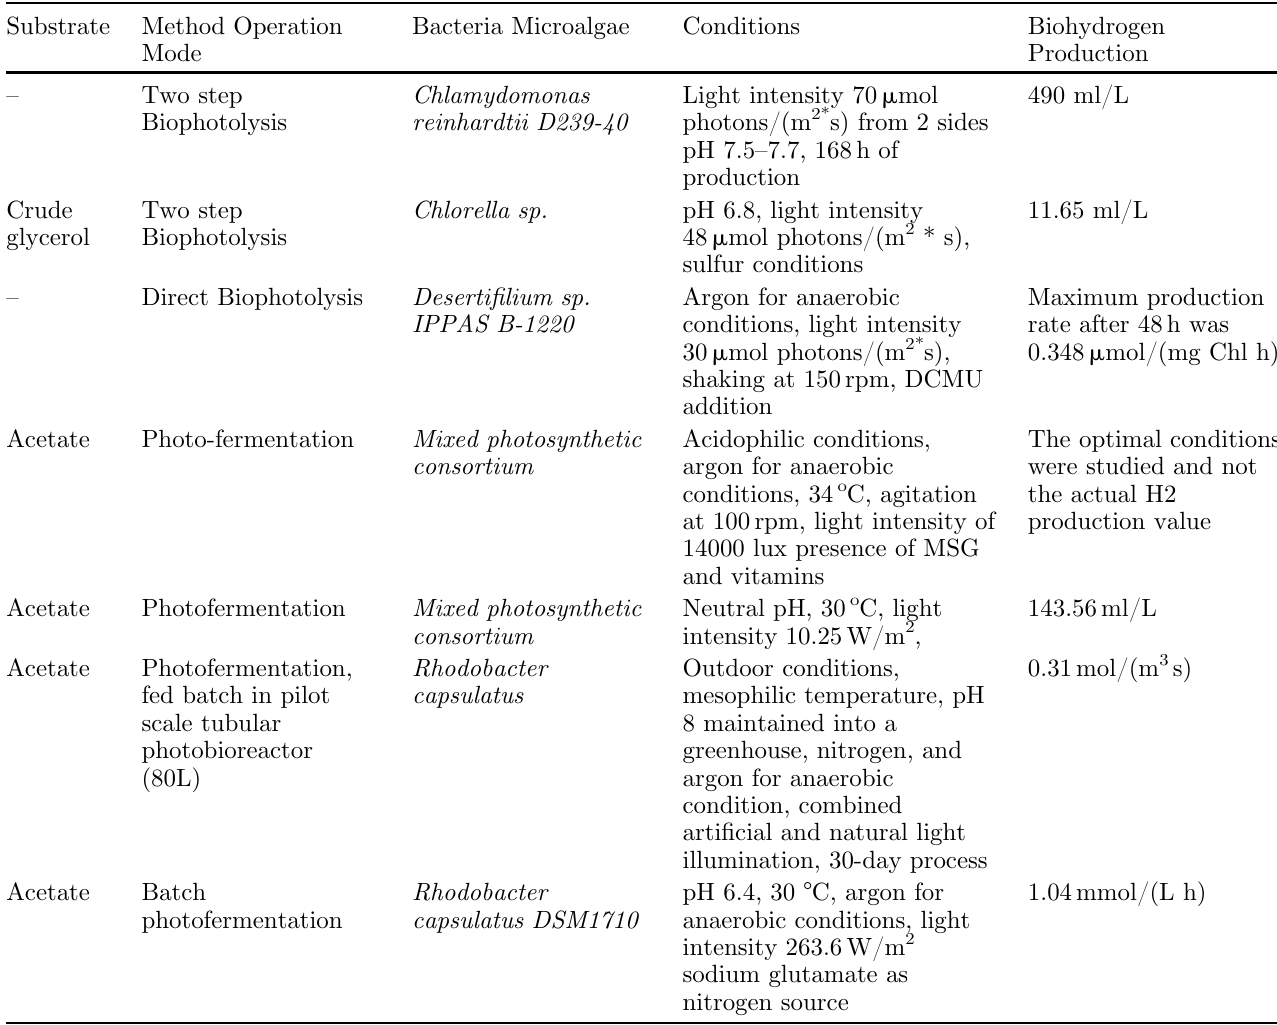
Table 11. Yields of biohydrogen based on experiments ’ results